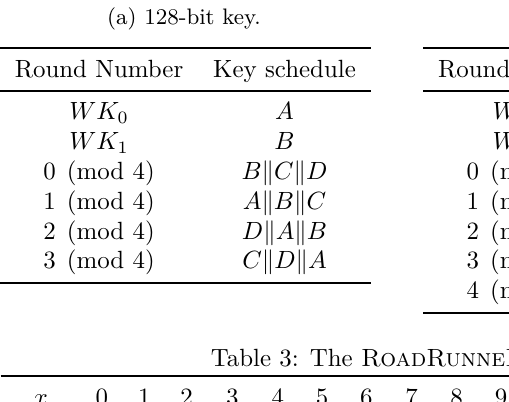
Table 2: RoadRunneR ’s key schedule.